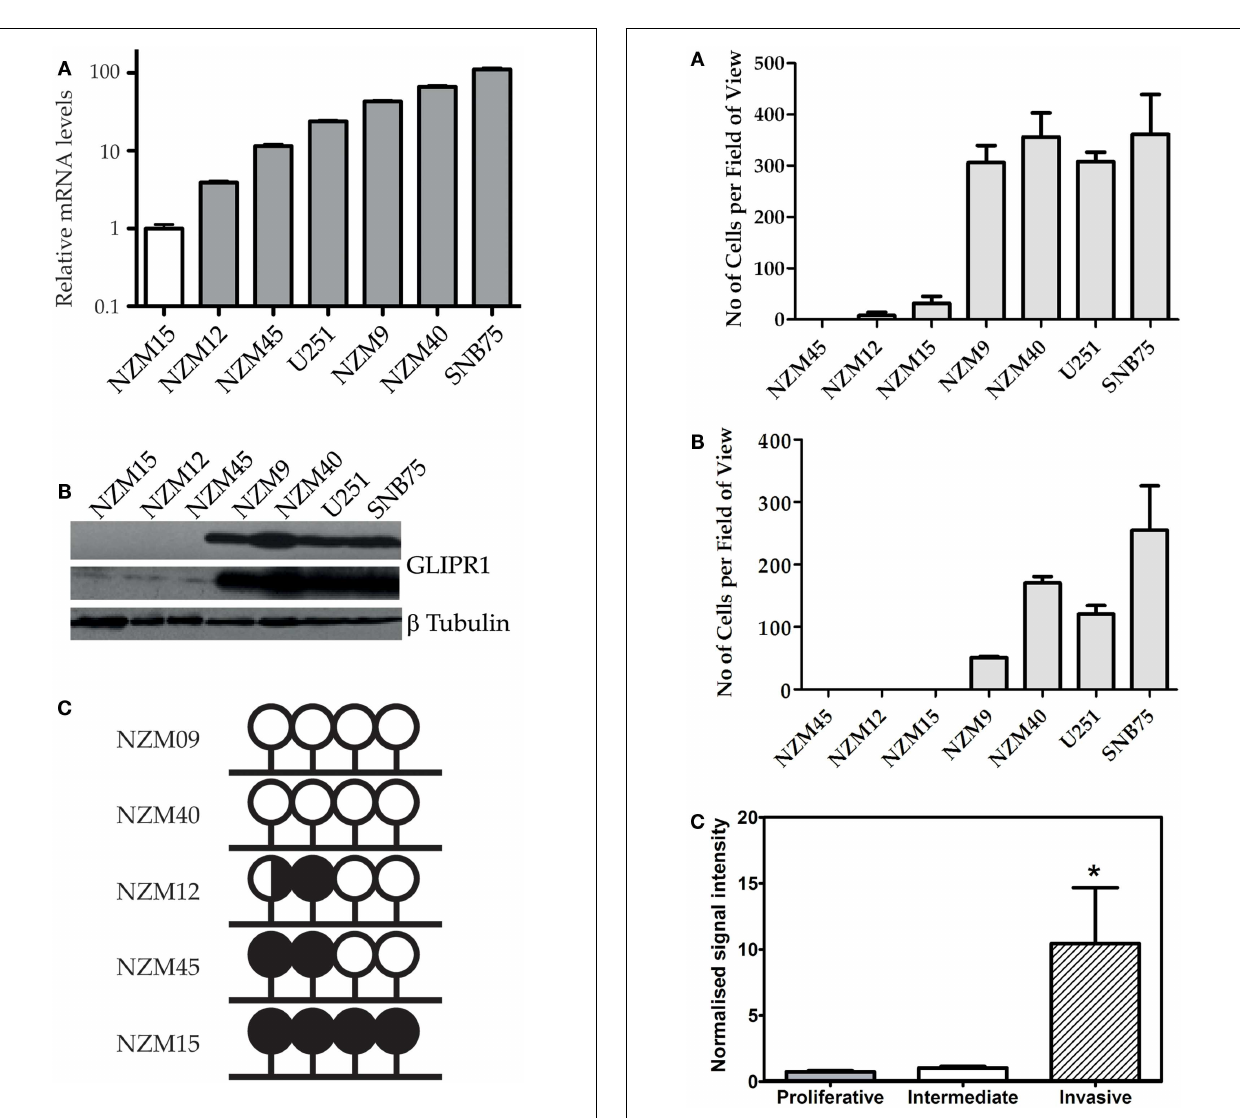
FIGURE 2 | GLIPR1 cell migration and invasion . Frequency with which melanoma and glioma cells cross a pored membrane by (A) migration or (B) invasion was assessed by microscope after 24h. Number of migrating or invading cells was calculated by counting the number of cells per field of view in 25 microscopic fields per well. Data shown as the average number of cells per field of view ± SEM from three (A) or two (B) independent experiments respectively. (C) GLIPR1 transcript levels were significantly higher in an independent panel of cell lines with experimentally validated invasive potential